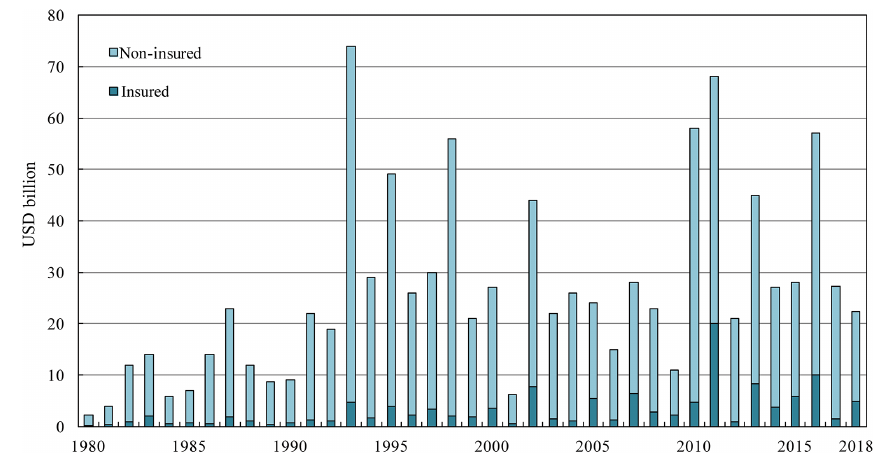
Figure 1. Global damage by hydrological events, in billions of US dollars (source: Munich Re NatCatSERVICE).